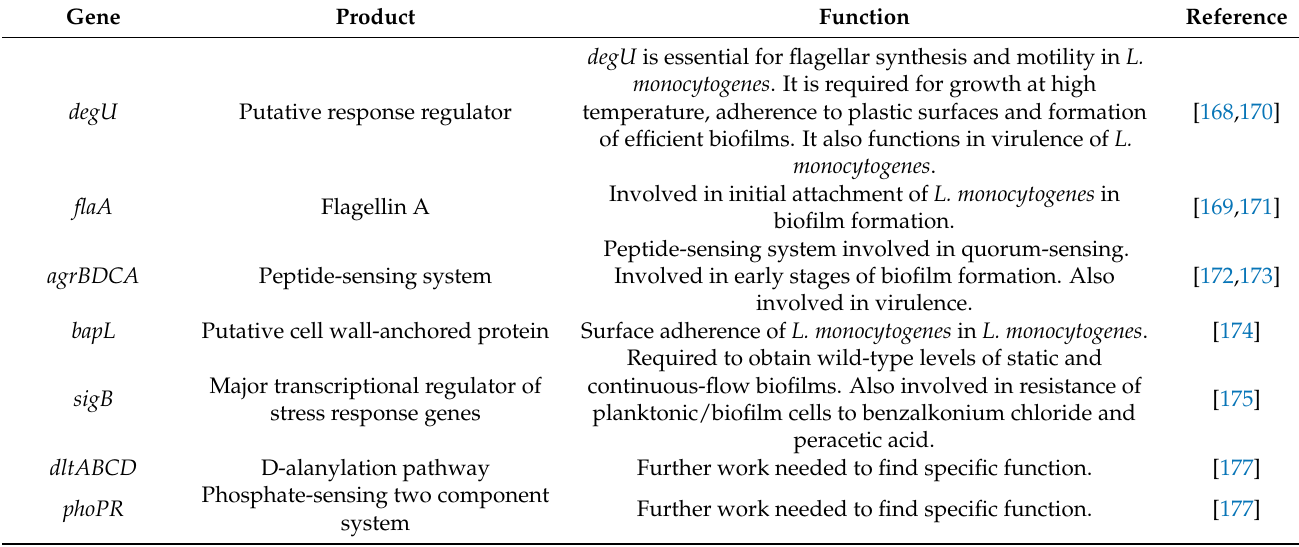
Table 5. Genes involved in biofilm production by L. monocytogenes